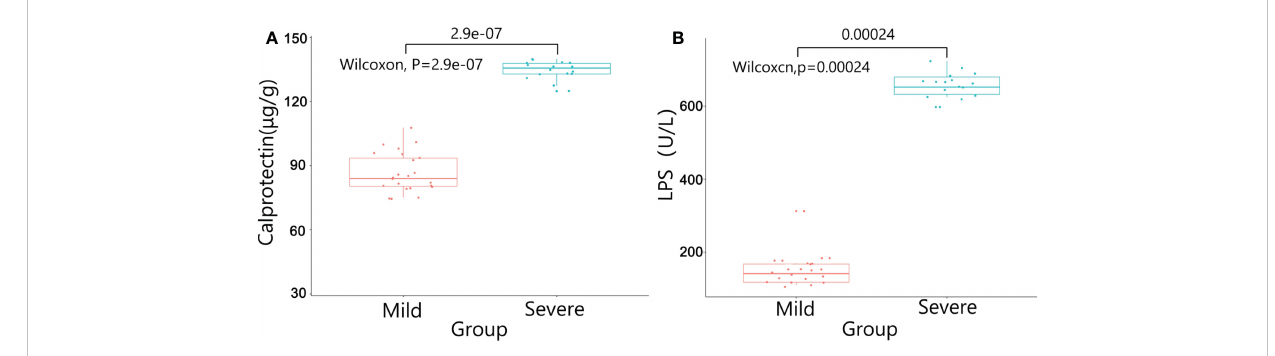
FIGURE 1 The results of Calprotectin and LPS between the two groups. (A) Calprotectin in anal lavage fl uid; (B) LPS in plasma.